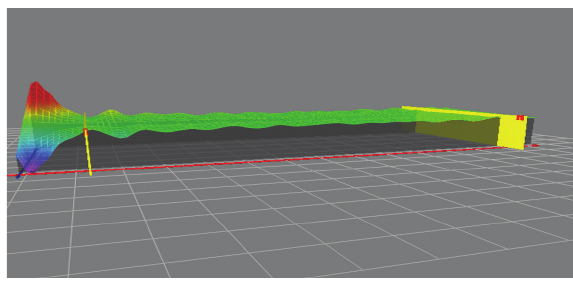
Figure 5: Surface characteristics—profilograph measurement.